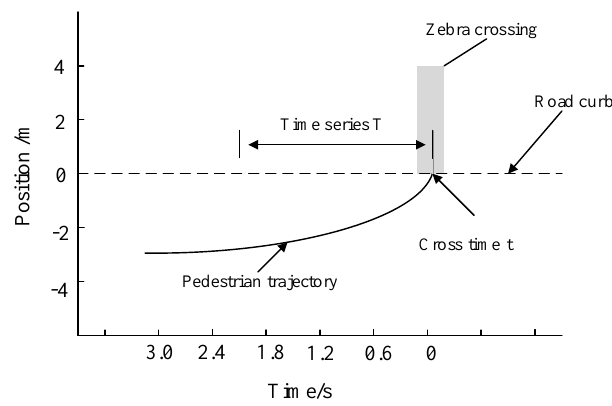
Figure 5. Time series of pedestrian crossing.